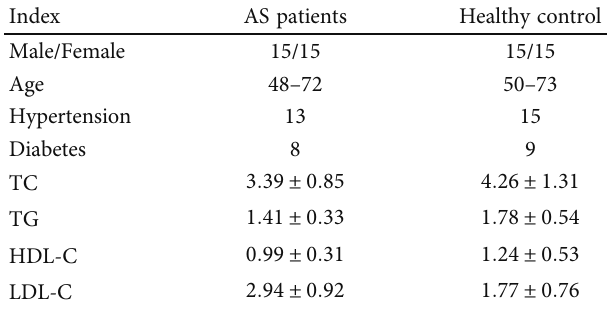
Figure 1: NFIA-AS1 is associated with the progression of AS. (a) Analysis from LncBook database showed that NFIA-AS1 was associated with AS. (b) The expression of NFIA-AS1 in the serum of AS patients and healthy volunteers was detected by qRT-PCR. (c) The expression of NFIA-AS1 in VSMCs and Ox-LDL-induced VSMCs was detected by qRT-PCR. (d) The level of TC, TG, HDL, and LDL in the serum of control and AS patients. ** P < 0 : 01 and *** P < 0 : 001 . Table 3: Clinical characteristics of the